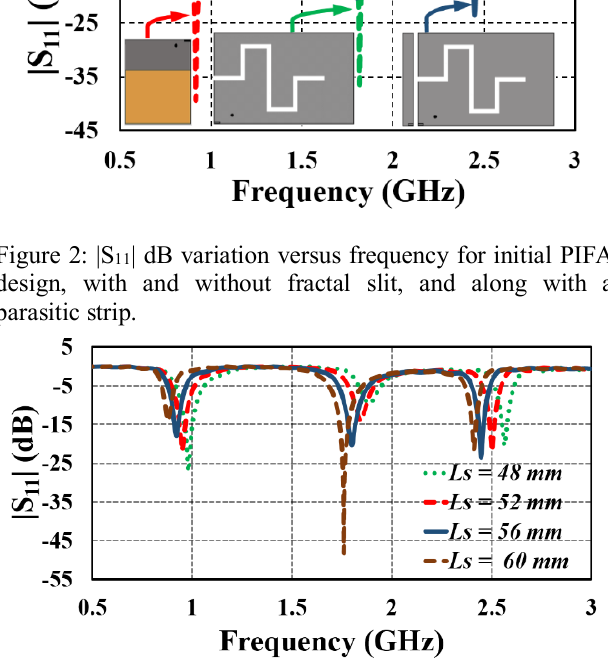
Figure 3: |S 11 | dB curve variation versus frequency for different total slit length ( L s